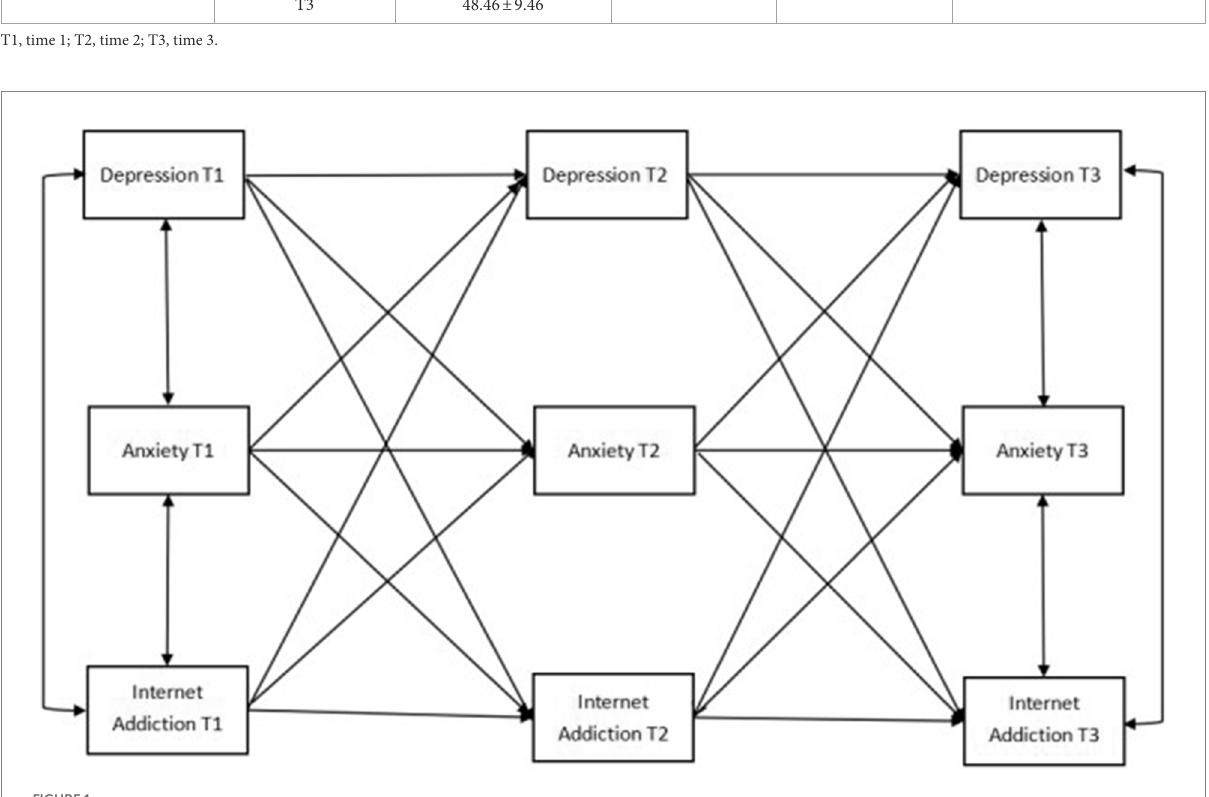
FIGURE 1 Cross-lagged theoretical model of depression, anxiety, and Internet